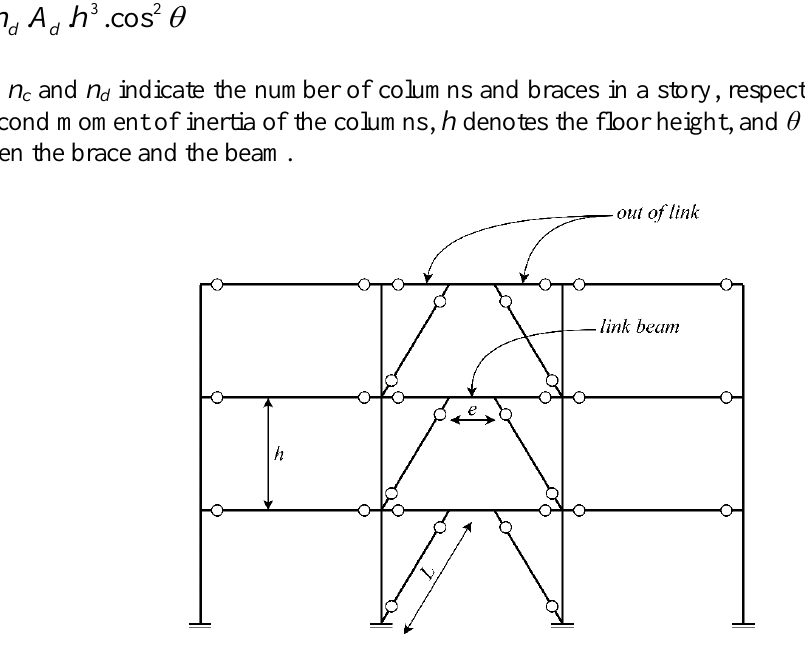
Figure 2. Typical configuration of